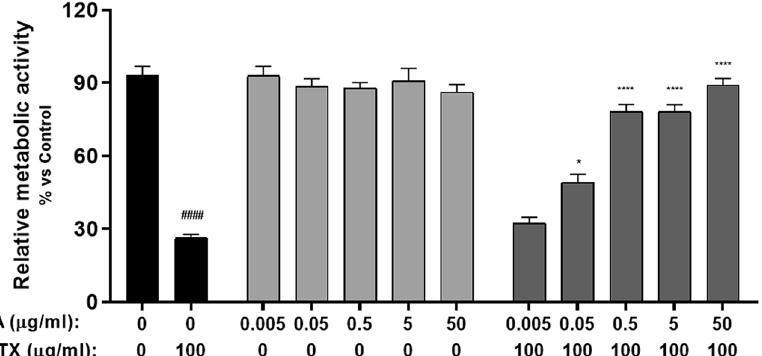
Figure 3. Folic acid dose response in MTX-induced mucositis organoids. Relative metabolic activity of organoids treated with 100 ng/mL MTX and the simultaneous addition of 0.005, 0.05, 0.5, 5 and 50 µg/mL folinic acid for 96 h (n = 3). Data is presented as mean ± SEM. # p < 0.05 for control organoids versus MTX- treated organoids. * p < 0.05 and p < 0.0001 for MTX-treated organoids versus MTX and FA-treated organoids.